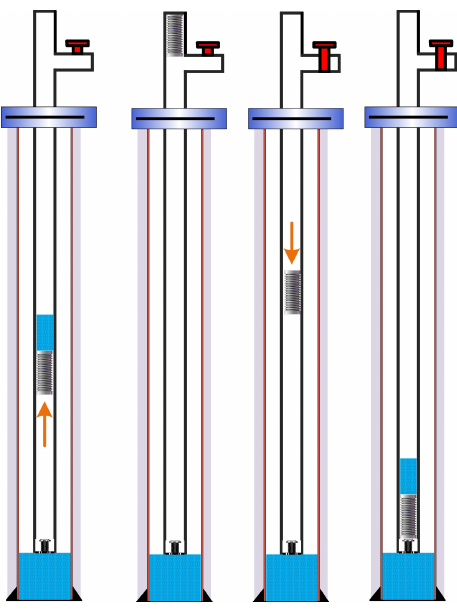
Fig. 1. Schematic diagram of typical plunger working